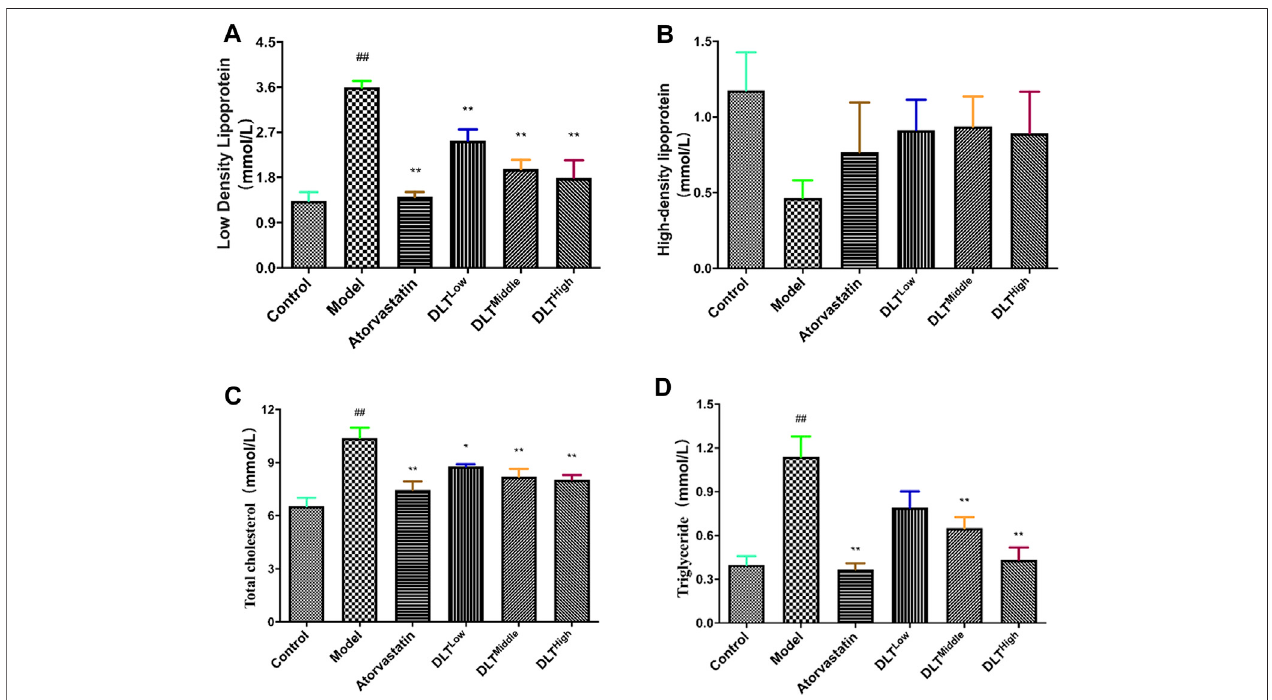
FIGURE 4 | DLTs in fl uenced plasma lipids following a 16 week high-fat diet in AS APOE - / - mice. (A) Low-density lipoprotein. (B) High-density lipoprotein. (C) Total cholesterol. (D) Triglyceride. The data are presented as the mean ± SD ( n (cid:2) 7). ## p < 0.01 vs the control group, and * p < 0.05, ** p < 0.01 vs the model group.